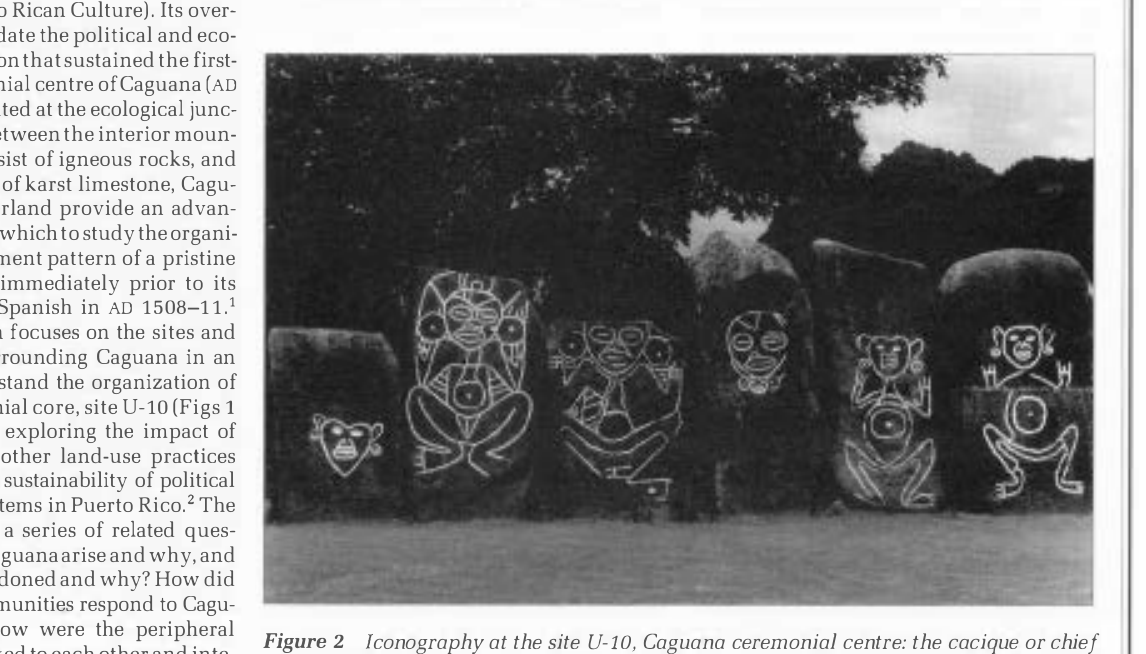
Figure 1 Aerial view of site U-10showing(a)a large plaza used for ritual dances (areito), (b) a rectangular area used for the Antillean ball game (batey}, (c) a small oval plaza, and (d) an area where evidence of houses has been found.